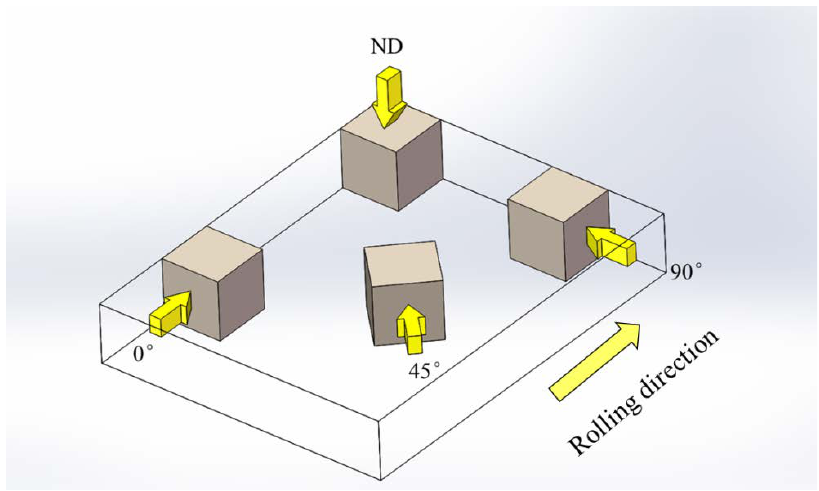
Figure 1. Schematic of the loading of rolled AZ31 alloys in four directions.